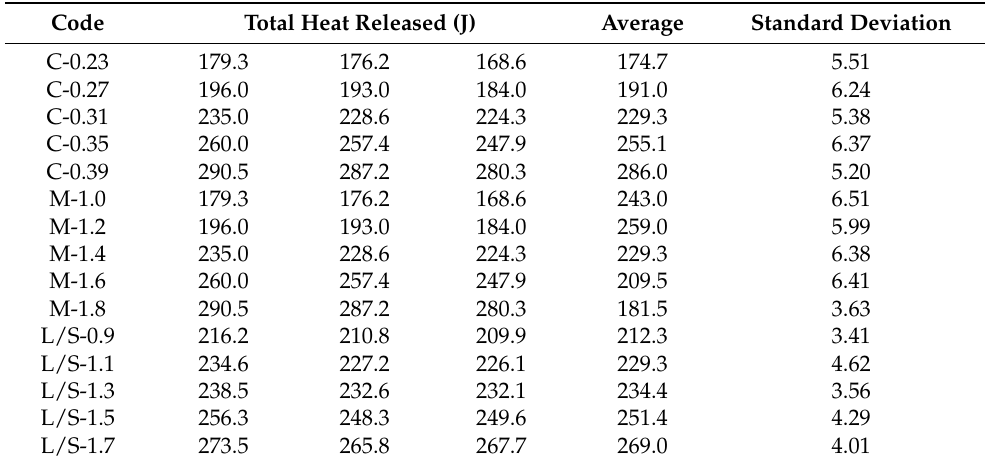
Table 3. Total heat released during the first 72 h.